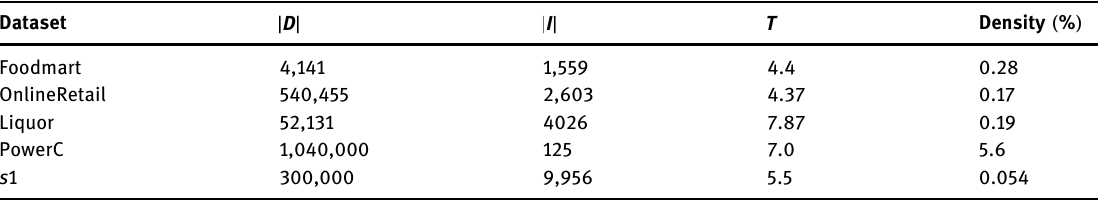
Table 10: Characteristics of datasets